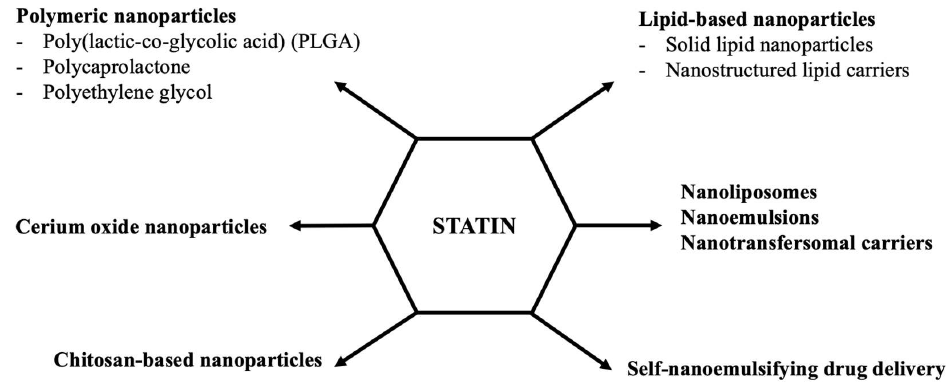
Figure 2. Proposed statin-loaded nanoparticle systems in targeted lipid-lowering therapy . Polymeric Nanoparticles